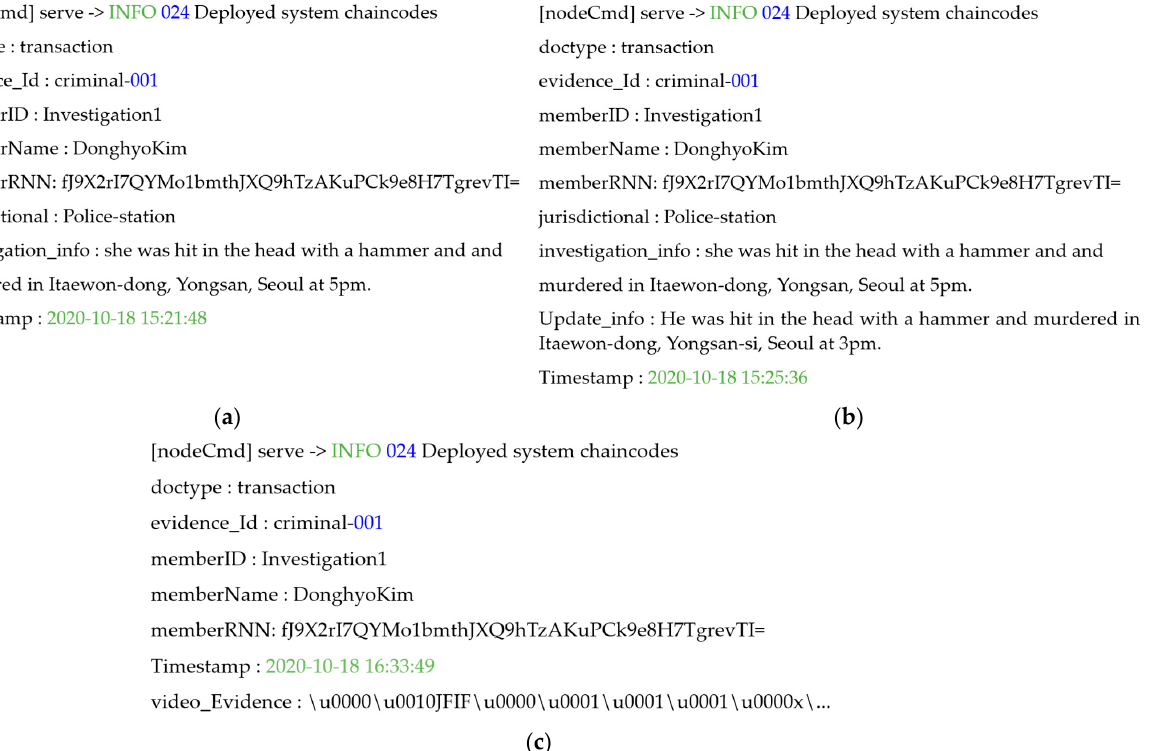
Figure 5. Save, update, and retrieve of the two-level blockchain system. ( a ) Saving the information of investigation and identity, ( b ) updating the information of investigation and identity, and ( c ) retrieving digital crime evidence videos.